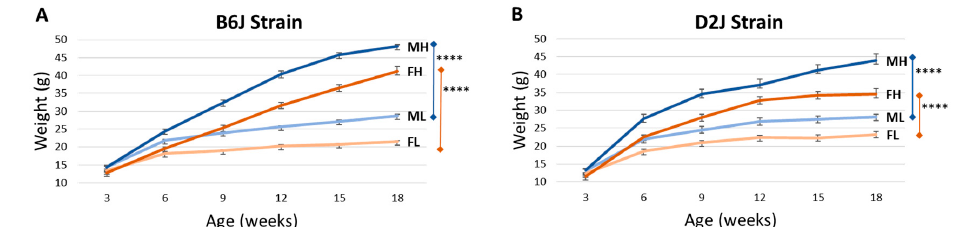
Figure 1. Weight gain by strain. Weight gain throughout the 16-week diet treatment for C57BL/6J (B6J) male and female mice ( A ) and DBA/2J (D2J) male and female mice ( B ). Letter codes are as follows: M = male, F = female, L = low-fat diet, H = high-fat diet. Data are represented as mean ± SEM. **** p < 0.0001.